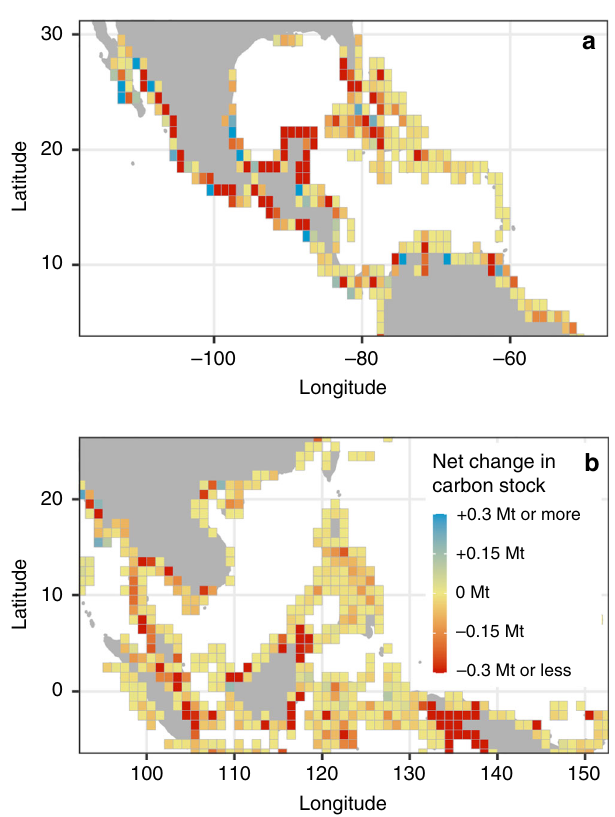
Fig. 3 Net changes in mangrove carbon stock in two hotspots of change. Net change in mangrove carbon stock was quanti fi ed as ( Fa t − Dr t ). a Central America and b Southeast Asia. Simulated values for each mangrove change patch were aggregated to a 1° grid resolution by taking the sum of all patches of mangrove gain and loss with centroids falling within each grid